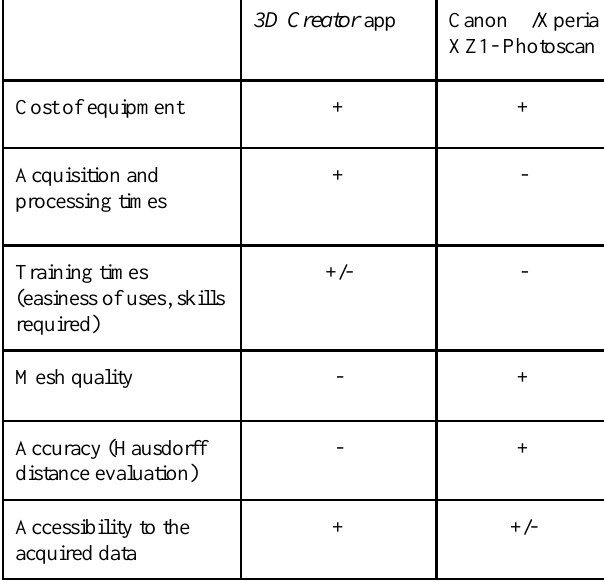
Table 1. Comparison between 3D Creator app and Photoscan